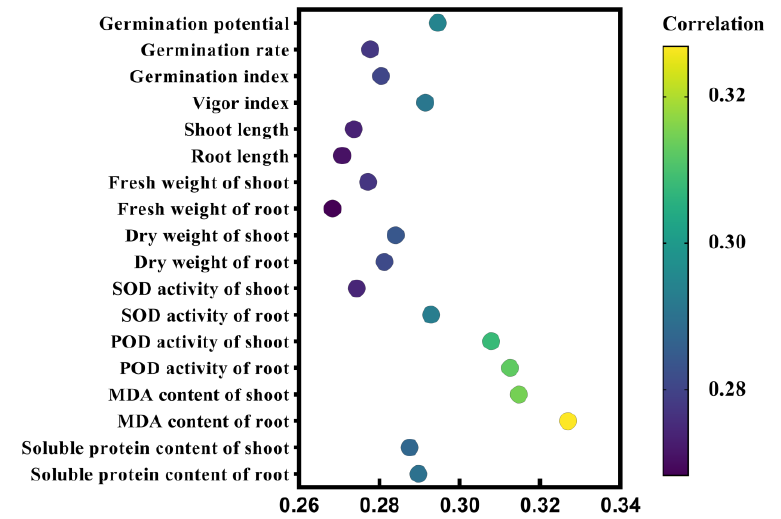
Figure 6. Analysis of the grey relational grade of melatonin and flooding